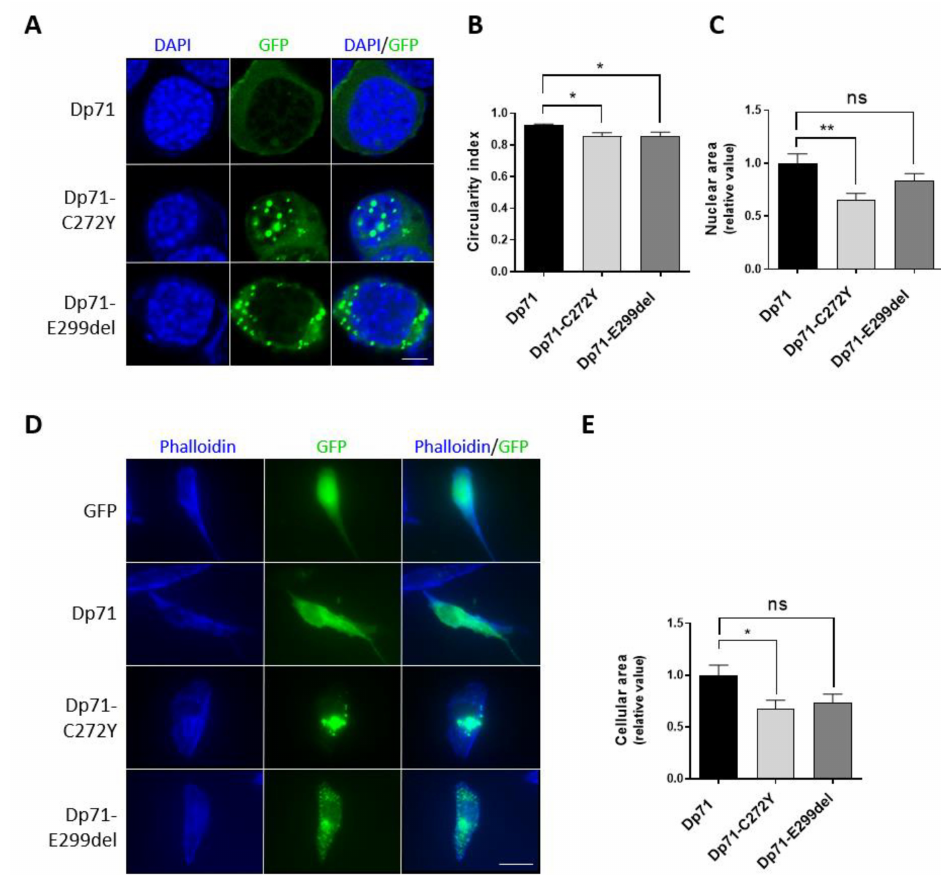
Figure 3. Effect of C272Y and E299del aggregates on neuronal cell morphology. ( A ) N1E-115 cells transiently expressing GFP, GFP-Dp71, Dp71-C272Y or Dp71-E299del were stained with DAPI to visualize nuclei, prior to being imaged by CLSM, and single typical optical Z-sections are shown (scale bar = 5 µ m). Morphometric analysis of the nucleus was carried out to measure ( B ) nuclear circularity and ( C ) nuclear area using Fiji software. ( D ) SH-SY5Y cells transiently expressing GFP, GFP-Dp71 or Dp71-C272Y and Dp71-E299del were stained with phalloidin to visualize the actin-based cytoskeleton, prior to being imaged by epifluorescence microscopy (scale bar = 20 µ m). ( E ) The cellular area was measured using ImageJ 1.53a software. Results represent the mean +/ − SEM of three independent experiments (n = 100 cells per experimental condition), with significant differences calculated by one-way ANOVA and Dunnett’s multiple comparison test (ns, not significant; *, p < 0.05; **, p <